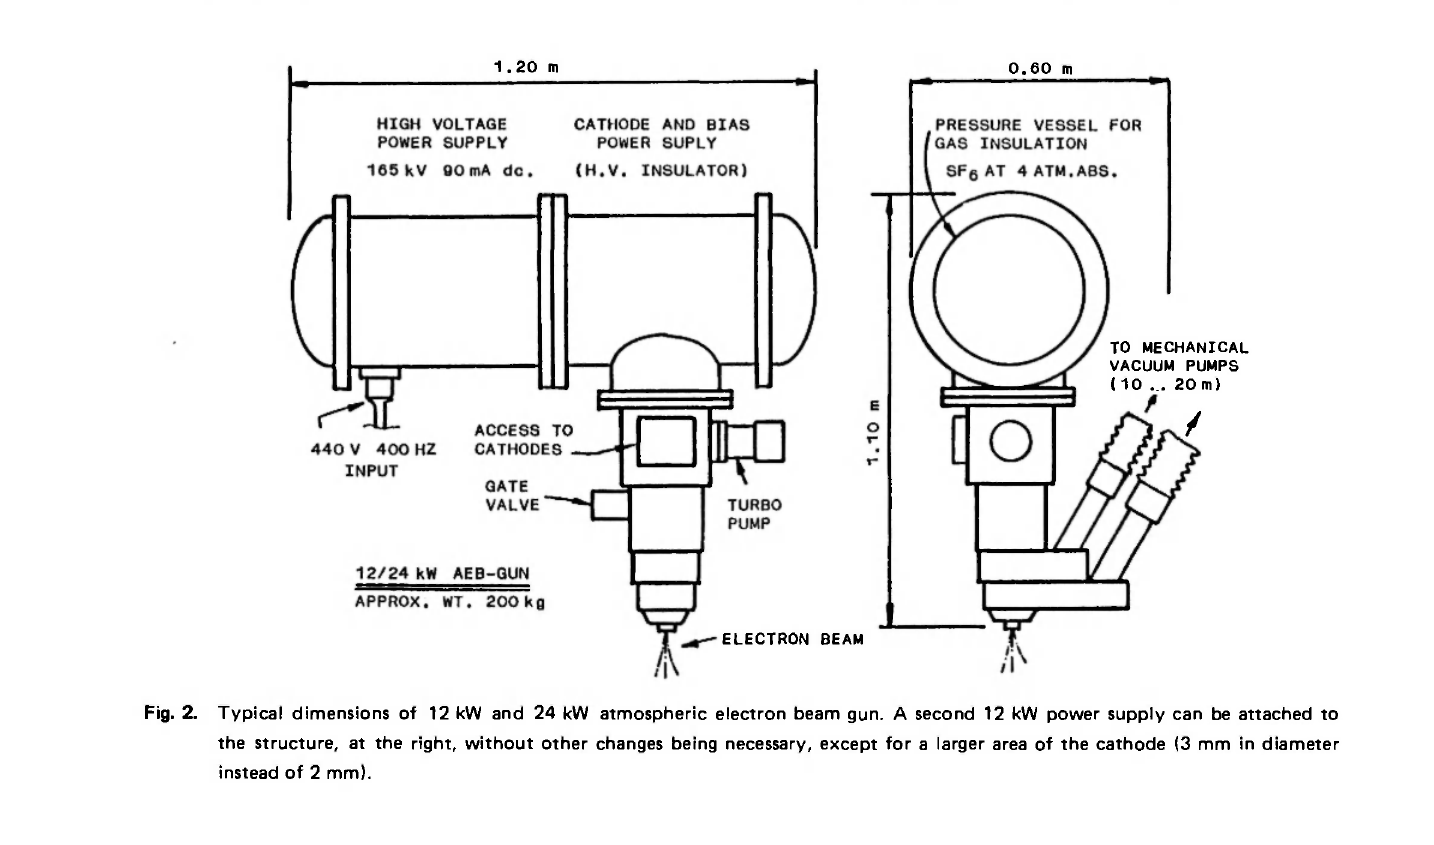
Fig. 2. Typical dimensions of 12 kW and 24 kW atmospheric electron beam gun. A second 12 kW power supply can be attached to the structure, at the right, without other changes being necessary, except for a larger area of the cathode (3 mm in diameter instead of 2